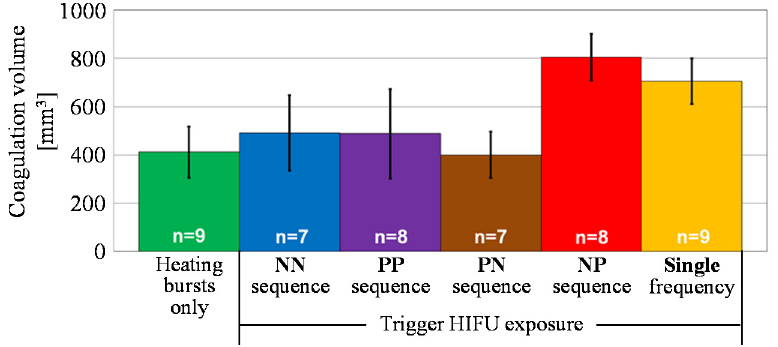
Figure 10. Average coagulation volumes of chicken breast tissues by various HIFU sequences similar to that shown in Figure 1b [33]. The total HIFU exposure was 11 s. For the trigger pulses, a single-frequency ultrasound at 0.8 MHz or dual-frequency ultrasound at 0.8 and 1.6 MHz as shown in Figure 3 with a duration time of 50 μ s and acoustic intensity of 10 kW/cm 2 was used. The focal points of trigger pulses were not shifted in this case. The same heating bursts were used in all sequences. The driving frequency was 1 MHz and the acoustic intensity was 1.7 kW/cm 2 , corresponding to an instantaneous total acoustic power of 51 W.